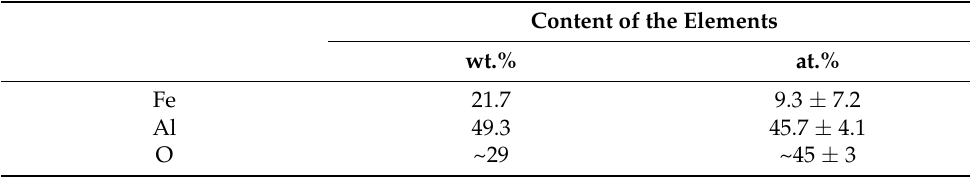
Table 7. Average results of SEM/EDS chemical composition tests on the surface of agglomerates formed from melted FeAl powder particles under specific DGS spraying conditions. Content of the Elements wt.%